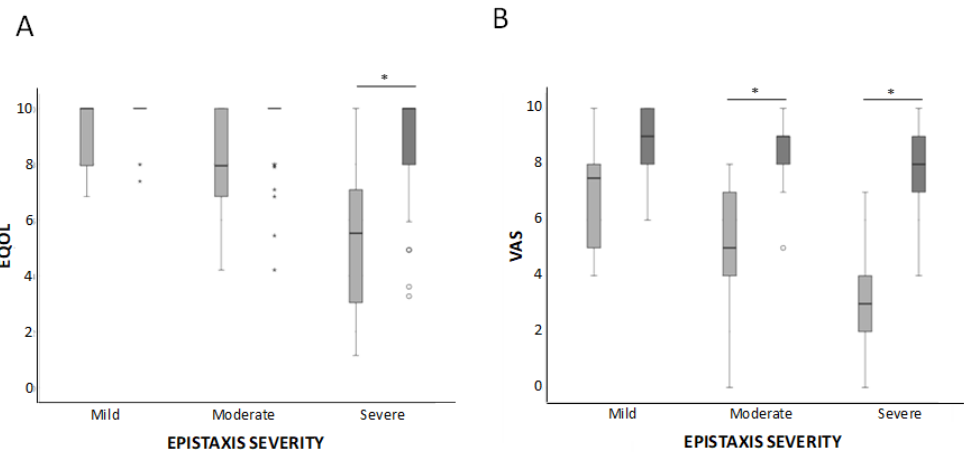
Figure 6. Box-whiskers plots corresponding to QOL parameters, EQ-5D ( A ) and VAS ( B ). Results are shown before and after the treatment in mild, moderate, and severe HHT-ESS patients. * p < 0.05.